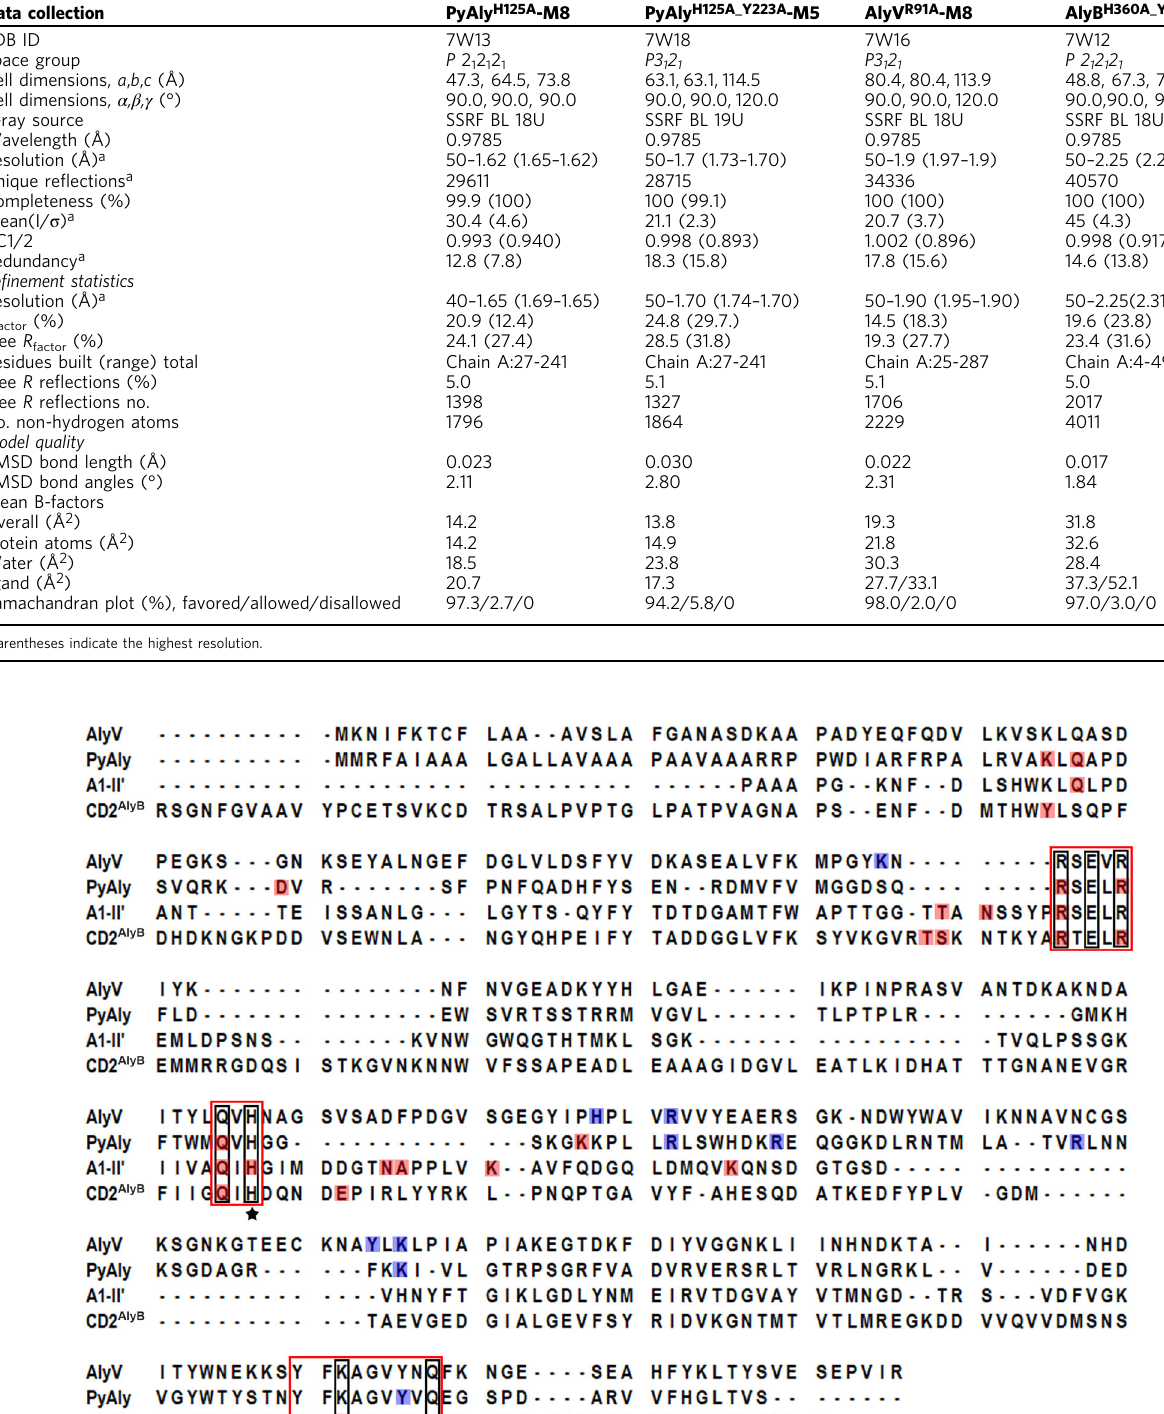
Table 1 Summary of data processing and re fi nement statistics.